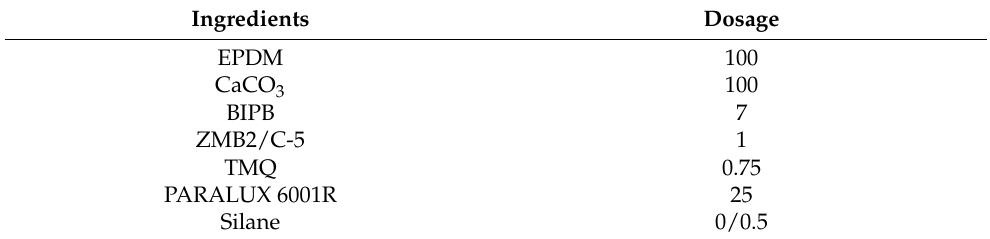
Table 1. RecipeusedtoprepareEPDM/CaCO 3 compounds; thevaluesareinPhr(partsperhundred